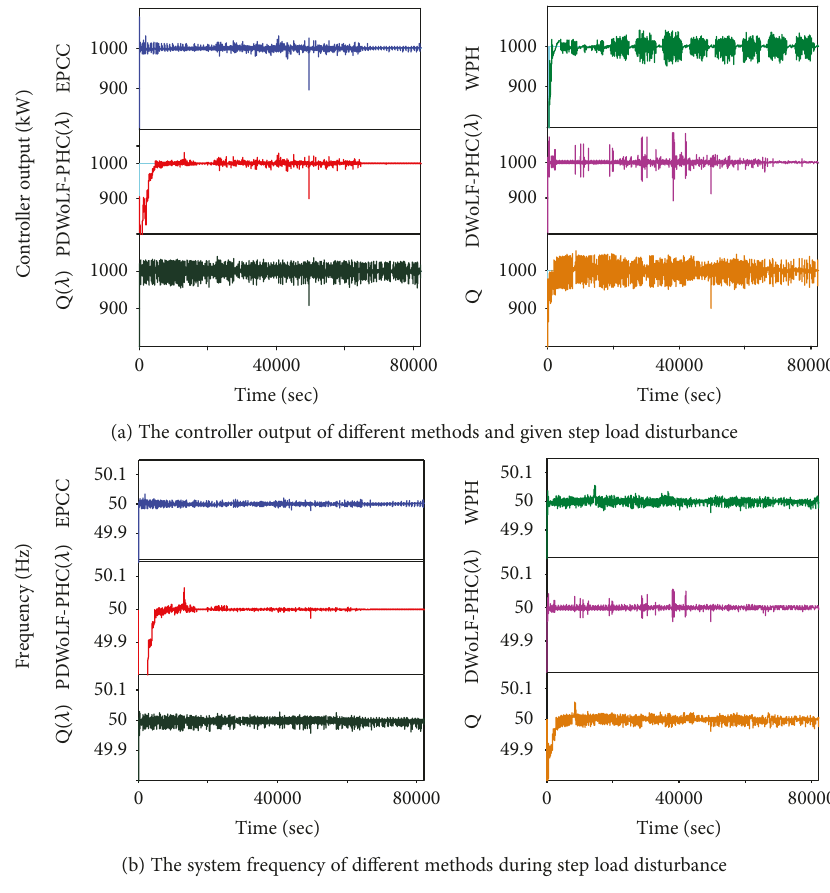
Figure 9: The control performance of di ff erent methods during step load